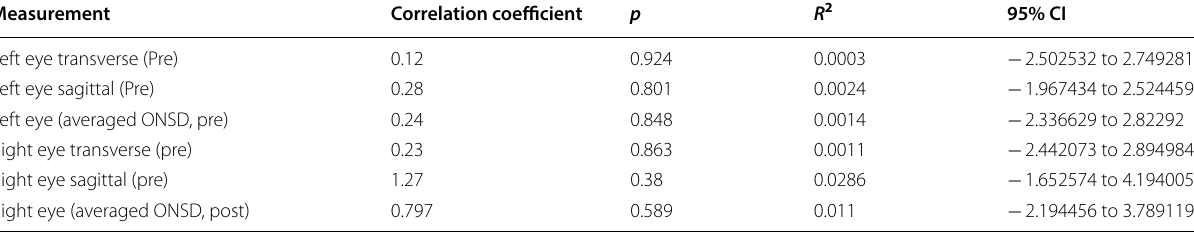
Table 4 Linear regression analysis of ONSD measurements to opening pressure Measurement Correlation coefficient